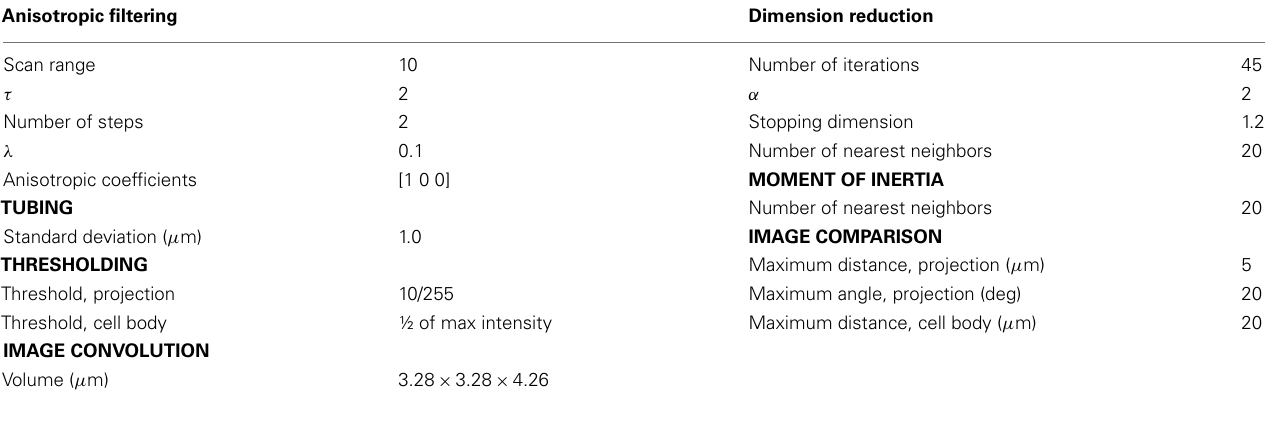
Table 1 | Parameters used in the